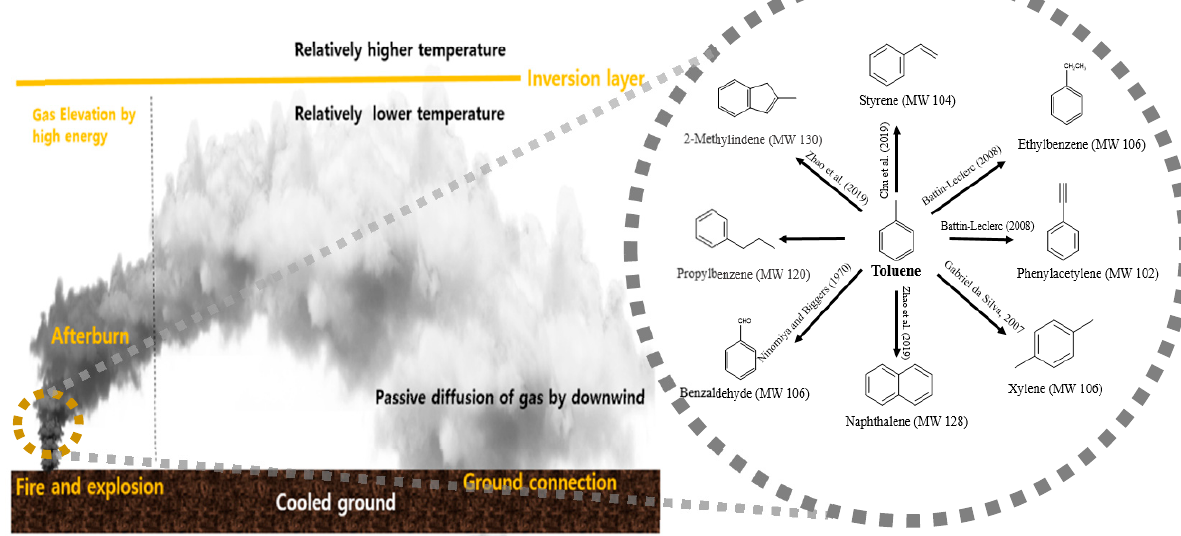
Figure 2. Modified image explaining soil pollution by gas cloud under the inversion layer, as suggested by [6], and schematic diagram showing the expectable combustion products with the formation mechanism proved by the following literature; 2-methylidene [10,13], toluene to ethenylbenzene (styrene) [13], toluene to ethylbenzene [14], toluene to ethynylbenzene (phenylacetylene) [14], toluene to xylene (dimethylbenzene) [16], toluene to naphthalene, toluene to benzaldehyde [17].